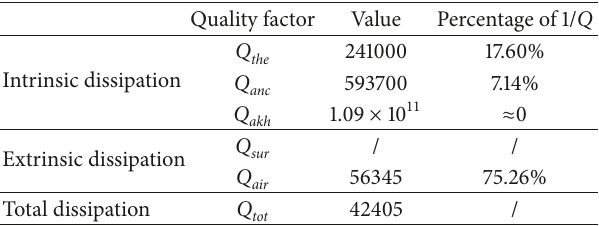
Figure 9: Quality factor Q 10Pa.